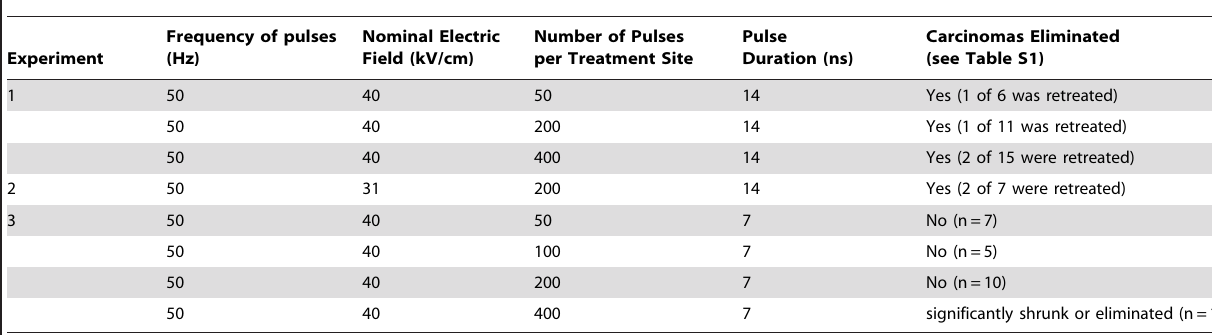
Table 3. Effect of nanosecond pulse electric fields on squamous carcinomas in vivo .